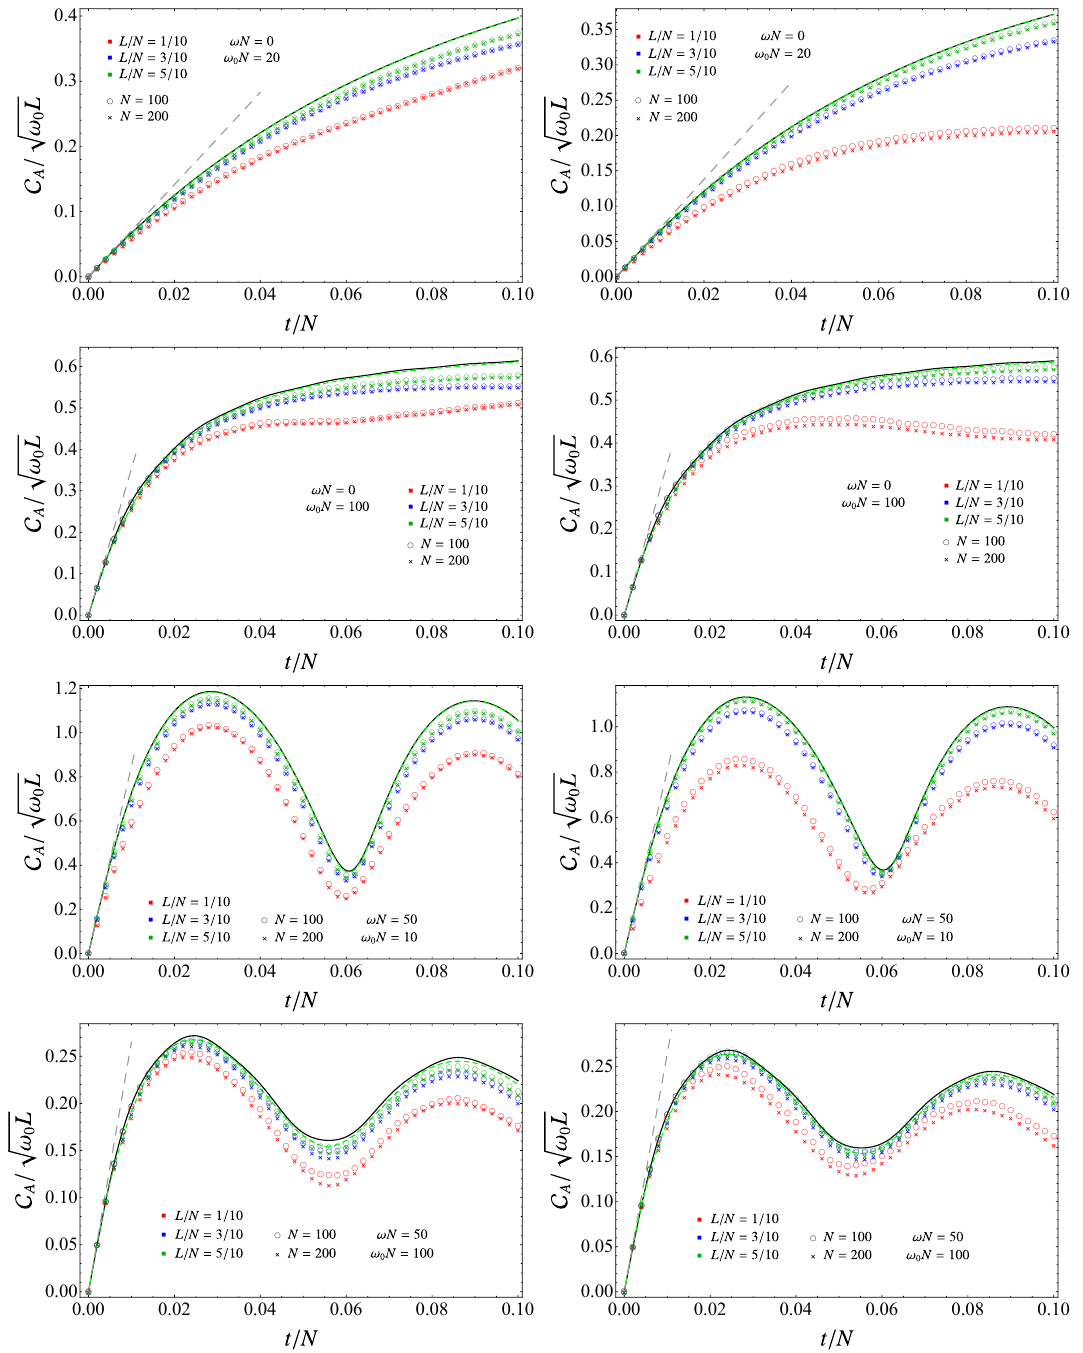
Figure 11 . Initial growth of C A in (4.6) for a block A made by L consecutive sites in harmonic chains with either PBC (left panels) or DBC (right panels) made by N sites (in the latter case A is adjacent to a boundary). When L = N , the complexity (3.7) is shown for N = 100 (solid